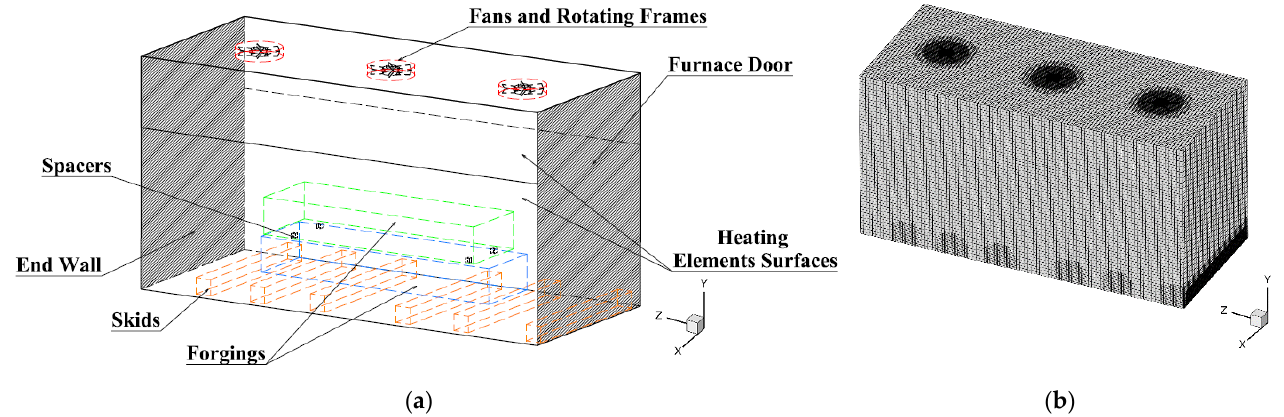
Figure 5. ( a ) The computational domain including solid zones, walls, heating elements surfaces, fans, and rotating frames and ( b ) computational grids for the CFD simulations.